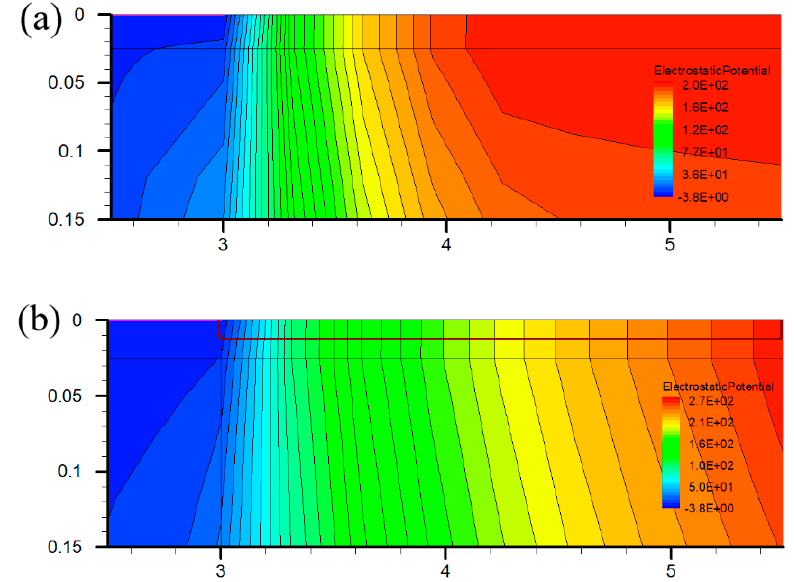
Figure 6. Distributions of the electrostatic potential of ( a )Con − HEMT and ( b )PDBS − HEMT.